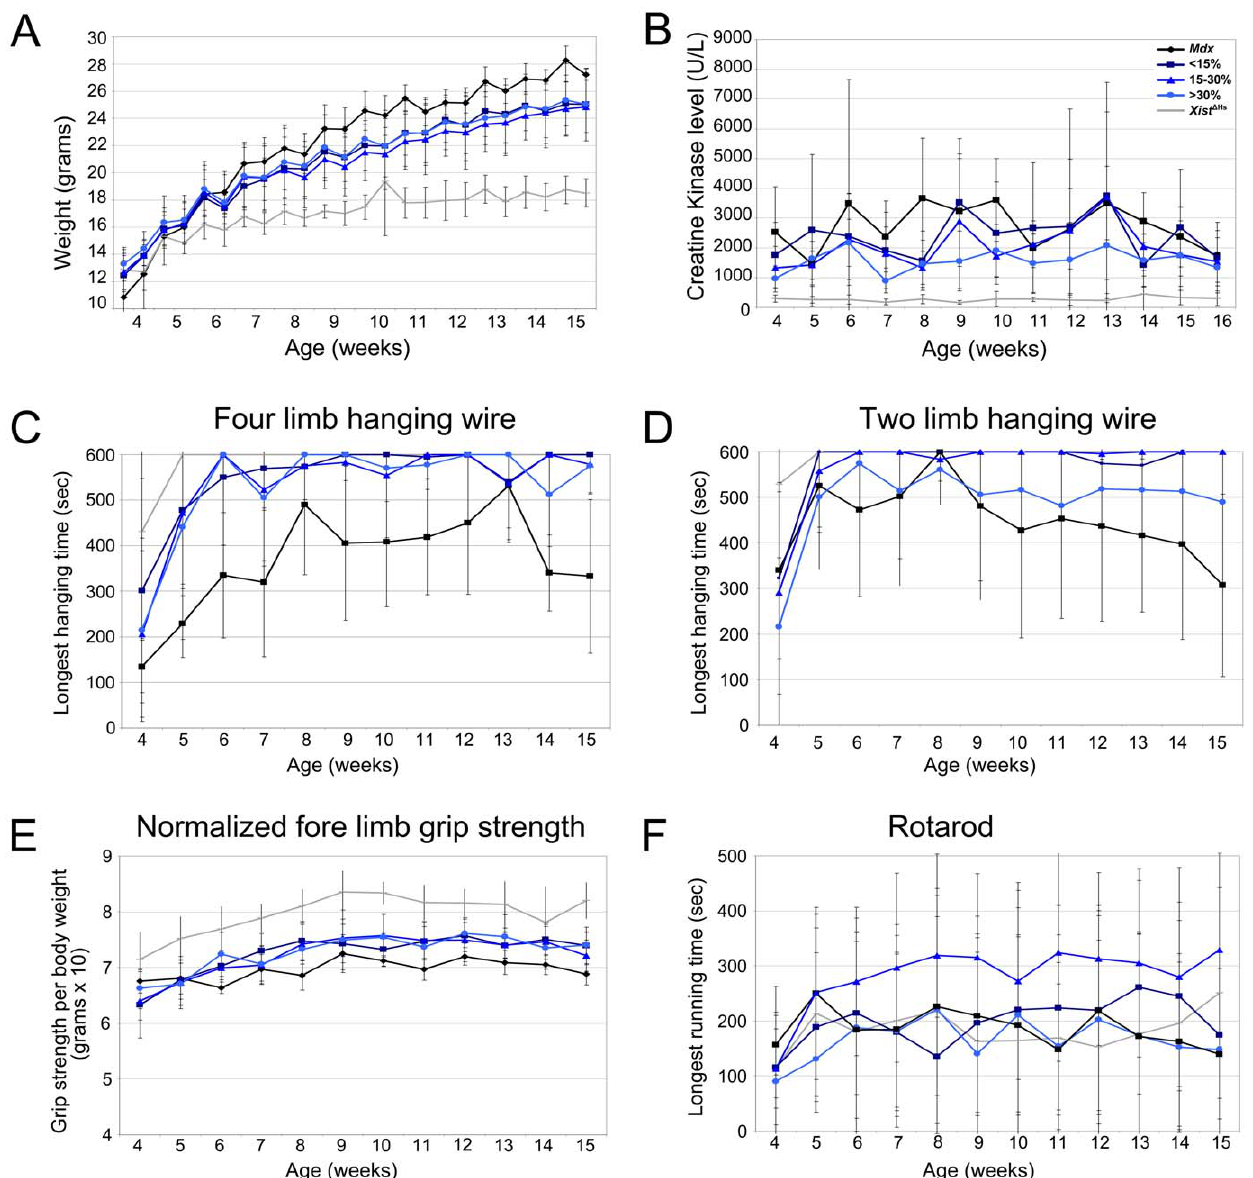
Figure 2. Body weight, CK levels and functional performance of the mouse models. A. Normalization towards wild type levels was observed for bodyweight of the mdx-Xist D hs mice. At the end of the functional test regime mdx mice were significantly heavier ( P , 0.001) than the other mice. B. CK levels of mdx and mdx-Xist D hs mice with low dystrophin levels were both significantly ( P , 0.001) higher compared to the levels of mdx-Xist D hs mice with . 30% dystrophin and Xist D hs mice. C. Four limb hanging wire performance was comparable for the Xist D hs and mdx-Xist D hs mice, while mdx mice performed significantly ( P , 0.001) worse. D. The best performance on the two limb hanging wire test was obtained for the Xist D hs , mdx-Xist D hs with , 15% and 15–30% while the mdx and mdx-Xist D hs with . 30% dystrophin performed significantly ( P , 0.001) worse. Bad performance of mdx-Xist D hs with . 30% was due to the bad performance of one individual mouse. E. Normalized fore limb grip strength was significantly ( P , 0.001) higher in the Xist D hs mice compared to the other strains and all the mdx-Xist D hs mice were significantly ( P , 0.001) stronger than the mdx mice. F. No difference in rotarod running was observed, except for the mdx-Xist D hs mice with 15–30% dystrophin, which performed significantly ( P , 0.001) better than all other